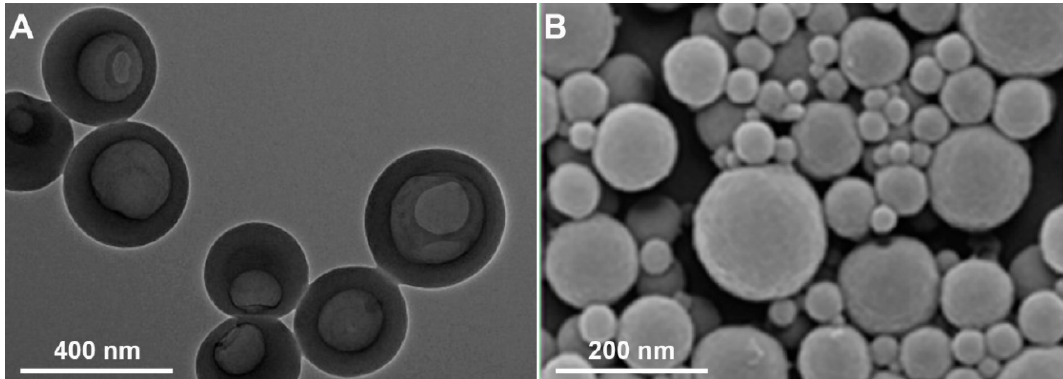
Figure 2. The morphology of LNPs prepared by ( A ) dropping the anti-solvent into the lignin solution (Reprinted with permission from ref [26]. Copyright © 2019 MDPI) and ( B ) dropping the lignin solution into the anti-solvent (Reprinted with permission from ref [18]. Copyright © 2020 American Chemical Society).